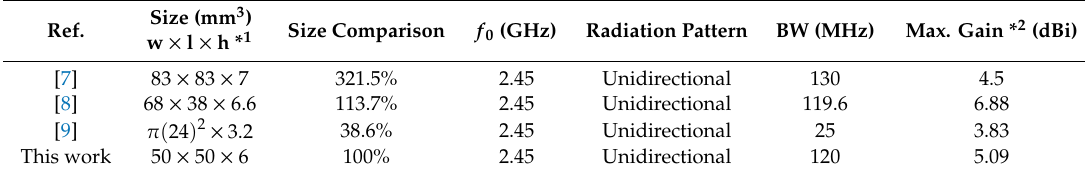
Table 3. Performance comparison with other state-of-art wearable